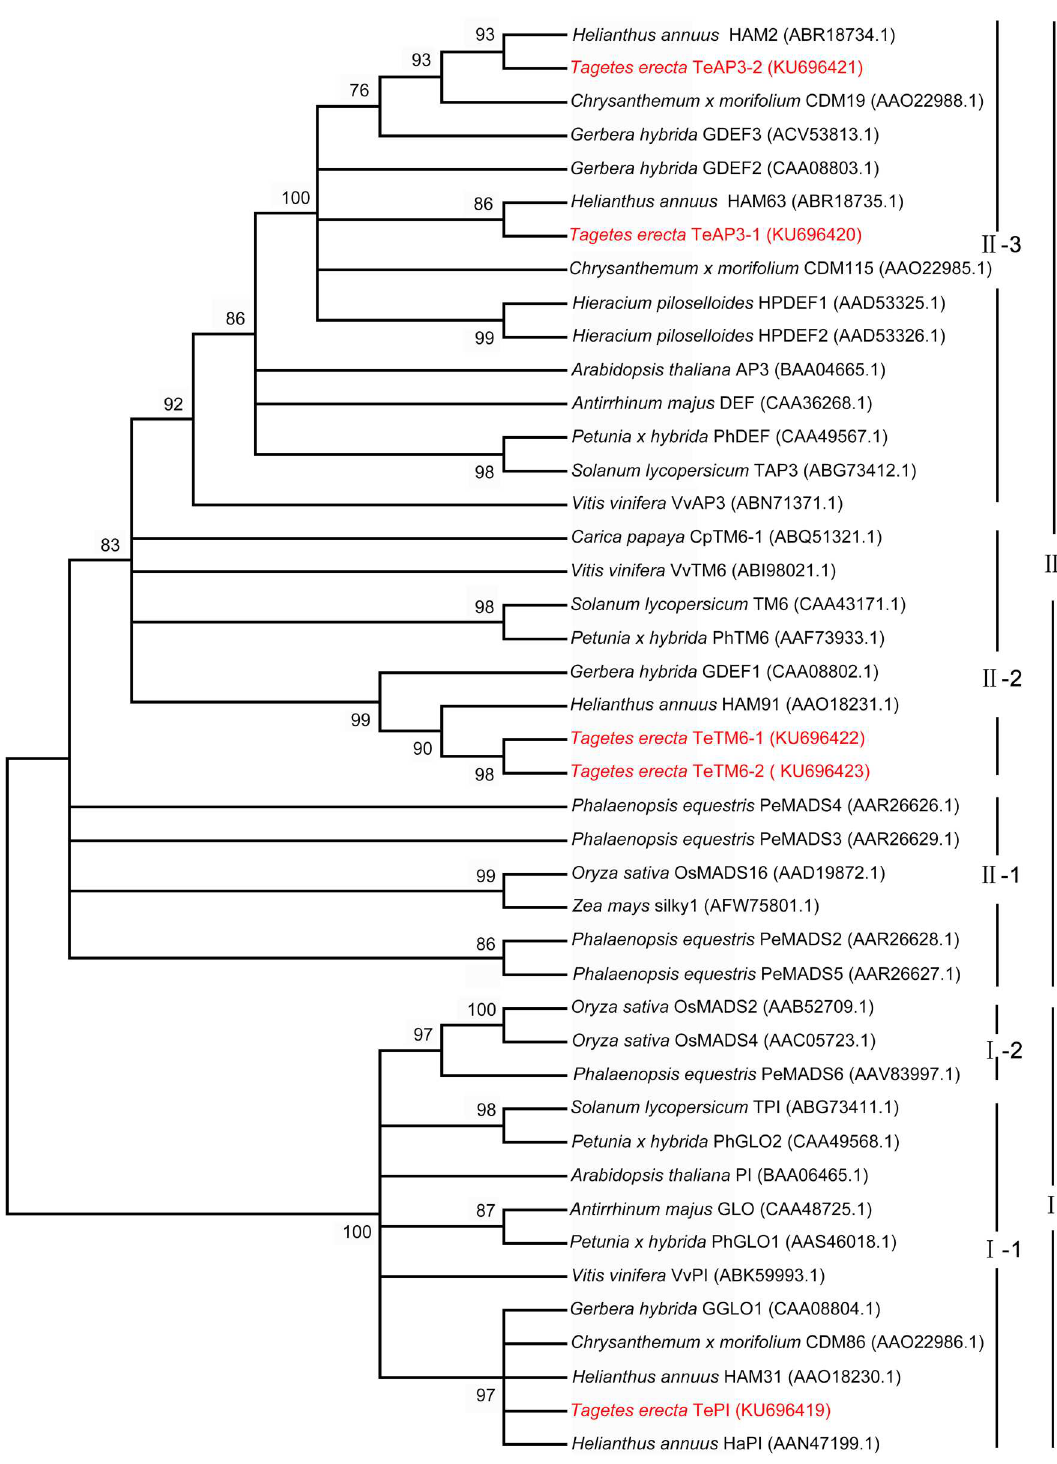
Fig 3. Phylogenetic tree calculated from the amino acid sequence of forty-two MADS-box B class genes. A phylogenetic tree was constructed based on the amino acid sequencesusing the maximum likelihood analysismethod. In addition to T . erecta , the full-lengthamino acid sequencesof MIKC domainswere selectedfrom 37 known PI/AP3 - homologous genes. The phylogenetic tree showed that the TePI protein was classified into the PI/GLO subfamily, TeAP3-1 and TeAP3-2 placed within the euAP3clade,whileTeTM6-1 and TeTM6-2 placed within the TM6 clade. Besides, TeAP3-1